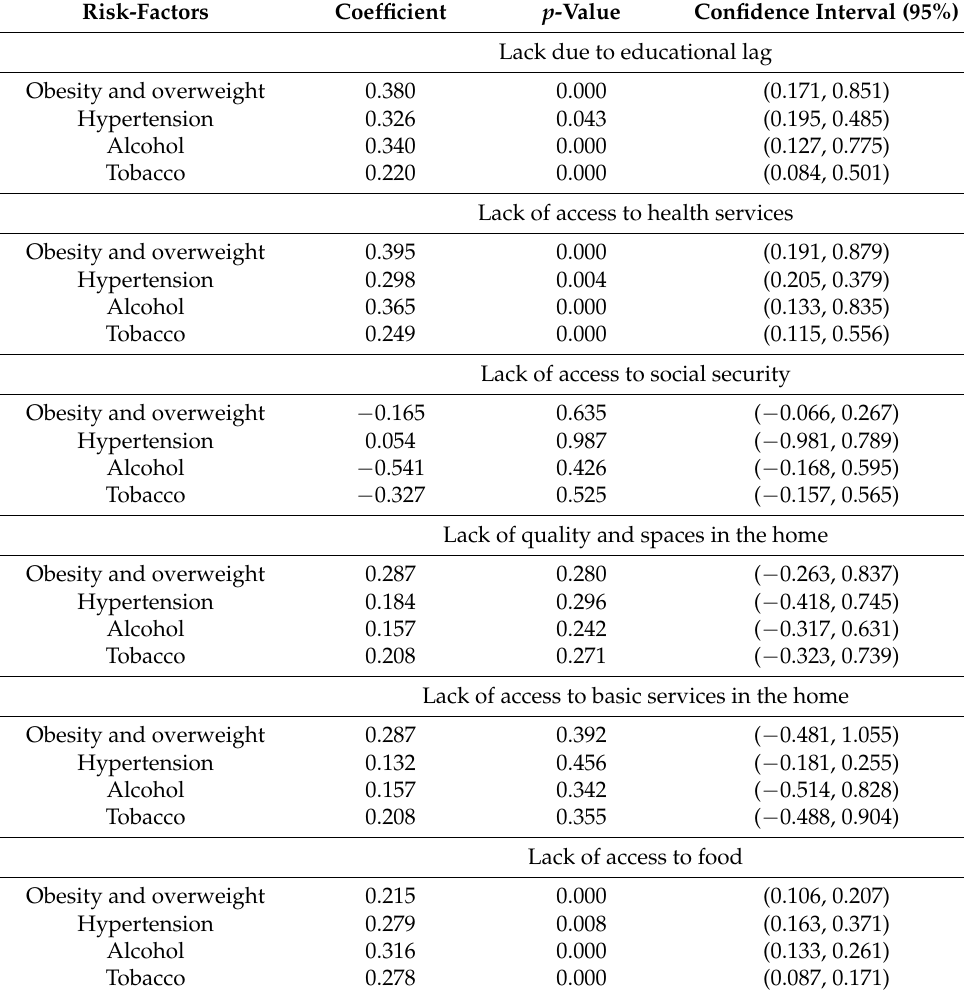
Table 10. Marginal effects on the probability of being diabetic (multinomial logit model) by type of clinical risk and social